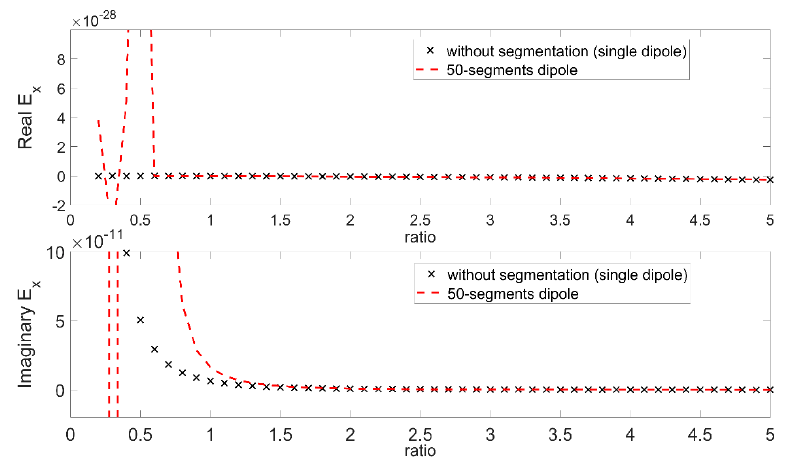
Figure 4. Comparison of the real and imaginary parts of the electric field component E x versus the ratio of the measurement distance to the cable length, for the Single Dipole Case (x marks) and the Segmented Dipole Case for N = 50 segments (dashed lines).